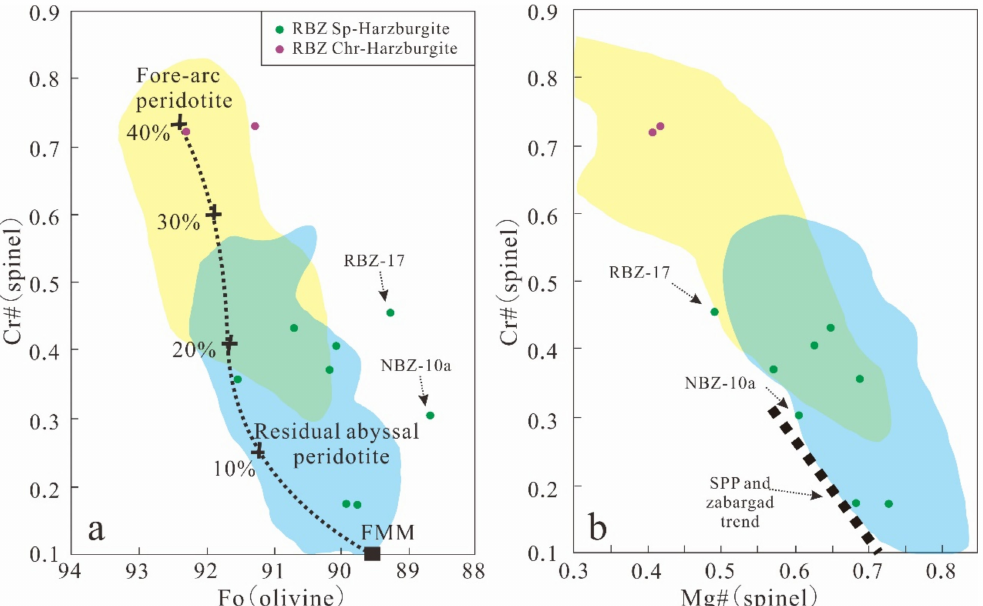
Figure 3. ( a ) Spinel Cr# versus olivine Fo values, and ( b ) spinel Mg# values for the Raobazhai harzburgites. The residual abyssal peridotite data is from [24], and fore-arc peridotites is from [25,26].